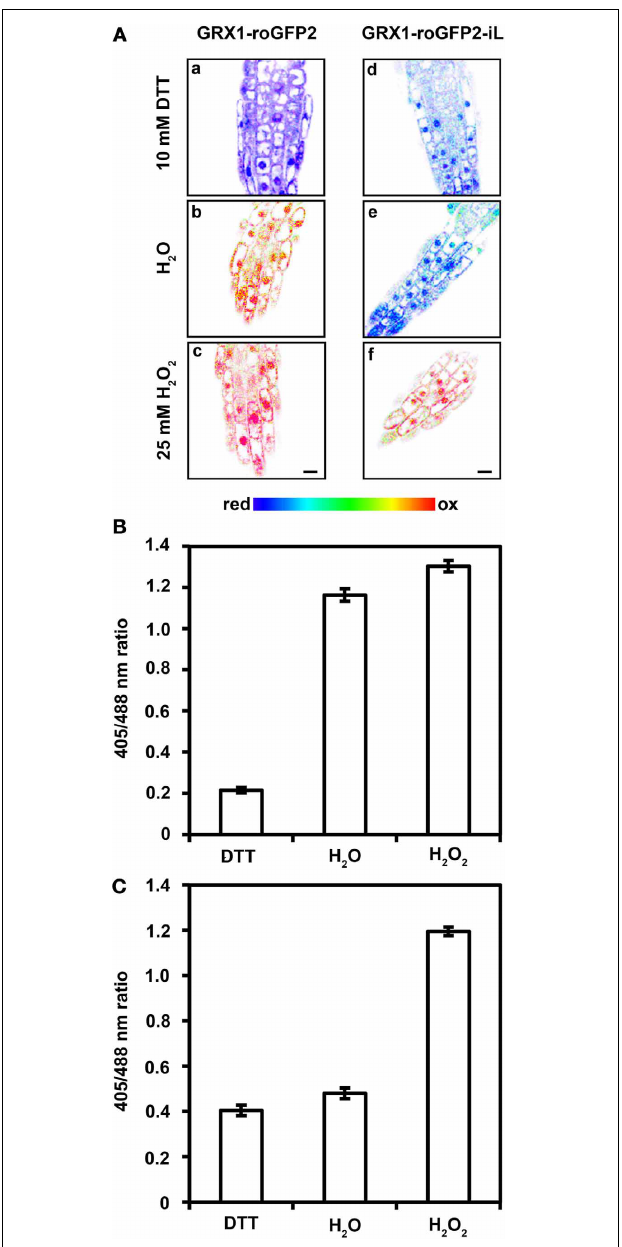
FIGURE 8 | The GRX1-roGFP2-iL probe expressed in the cytosol of homozygous rml1 mutants is almost completely reduced while GRX1-roGFP2 is highly oxidized. (A) Ratiometric images (a–f) show the redox state of GRX1-roGFP2 and GRX-roGFP2-iL in the cytosol of root epidermal cells of rml1 mutants. Treatment with 10mM DTT results in full reduction of GRX1-roGFP2 (a) and GRX-roGFP2-iL (d) , while under resting conditions GRX1-roGFP2 is highly oxidized (b) whereas GRX1-roGFP2-iL is in a reduced state (e) . Treatment with 25mM H 2 O 2 results in complete oxidation of GRX1-roGFP2 (c) and GRX-roGFP2-iL (f) . Scale bar 10 μ m. ( B,C ) Fluorescence ratio of cytosolic GRX1-roGFP2 (B) and GRX1-roGFP2-iL (C) show complete reduction and oxidation of GRX-roGFP2 and GRX1-roGFP2-iL after treatment with 10mM DTT and 25mM H 2 O 2 , respectively. Under resting conditions in H 2 O, GRX1-roGFP2 is highly oxidized while GRX1-roGFP2-iL is highly reduced. Values are calculated as the mean ± SD ( n = 5 − 10).